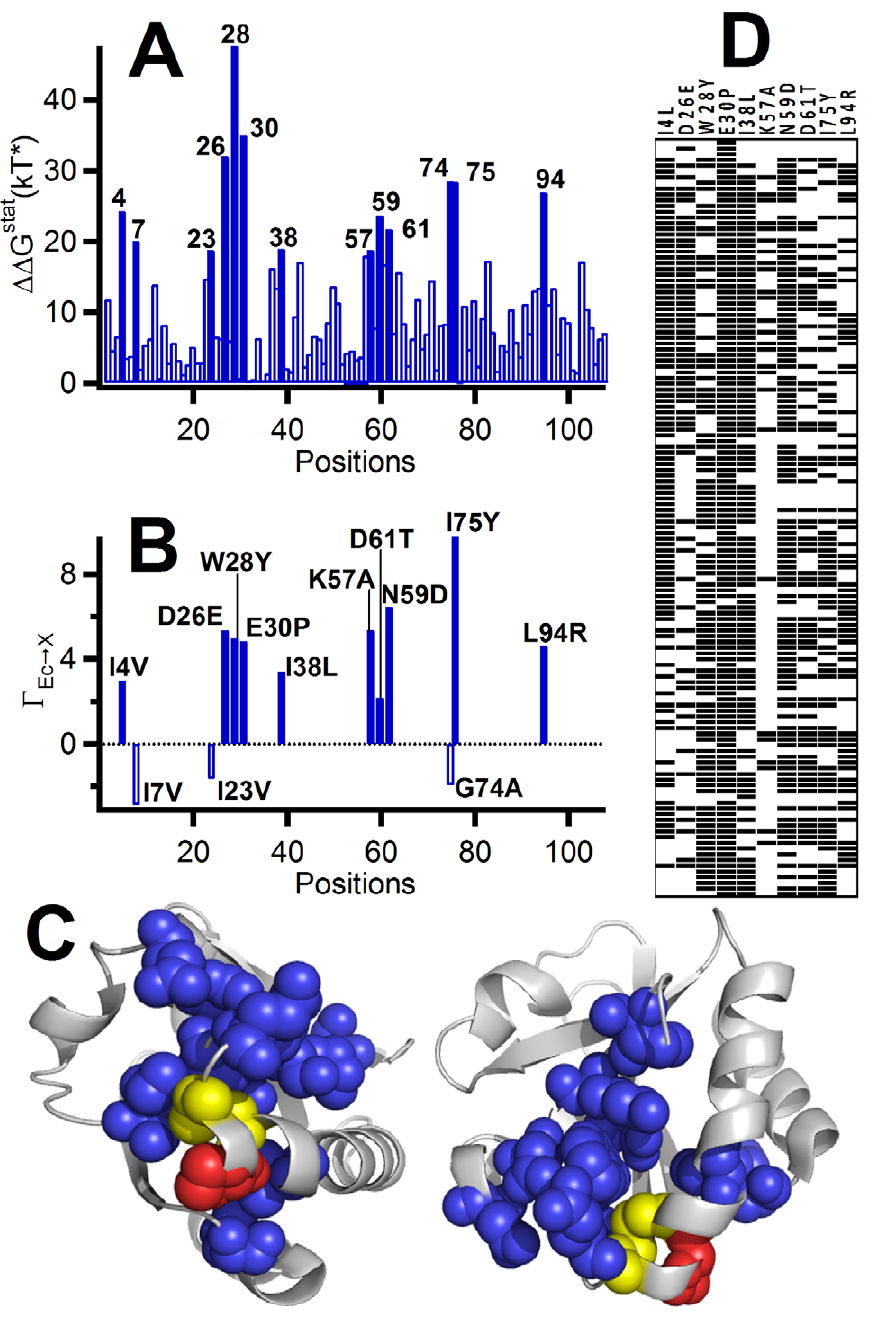
Figure 4. Statistical coupling analysis of the emergence of folding catalysis activities in thioredoxin domains. (A) Statistical free energies for the coupling of position 34 with all the other positions ( E. coli thioredoxin numbering is used). These values have been calculated using as perturbation the signature P34H mutation. The 13 positions with the highest values for the coupling energies are labeled. (B) Determination of ten favored mutations at the positions selected in step 1 (see text for details and for the definition of the C Ec R X function. (C) Mapping of the 10 positions selected for mutation (panel B) on the E. coli thioredoxin 3D structure (blue). The active site disulfide bridge is shown in yellow and the proline at position 34 is shown in red. (D) Occurrence of the 10 mutations selected (panel B) in the MSA sequences that include a histidine at position 34. Most of these sequences belong to eukaryotic protein disulfide isomerases. Note that many different combinations of these mutations are actually found in extant PDIs.